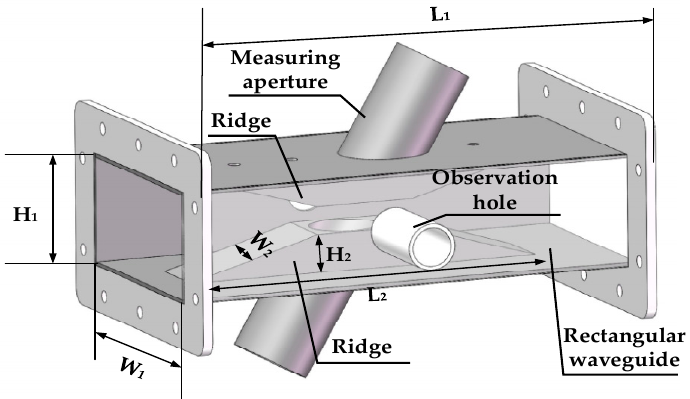
Figure 2. Schematic of the oblique aperture ridge waveguide. Table 1. Structure dimension table of the oblique aperture ridge waveguide.